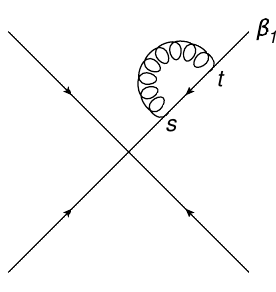
Figure 1 . The self-energy web at one-loop